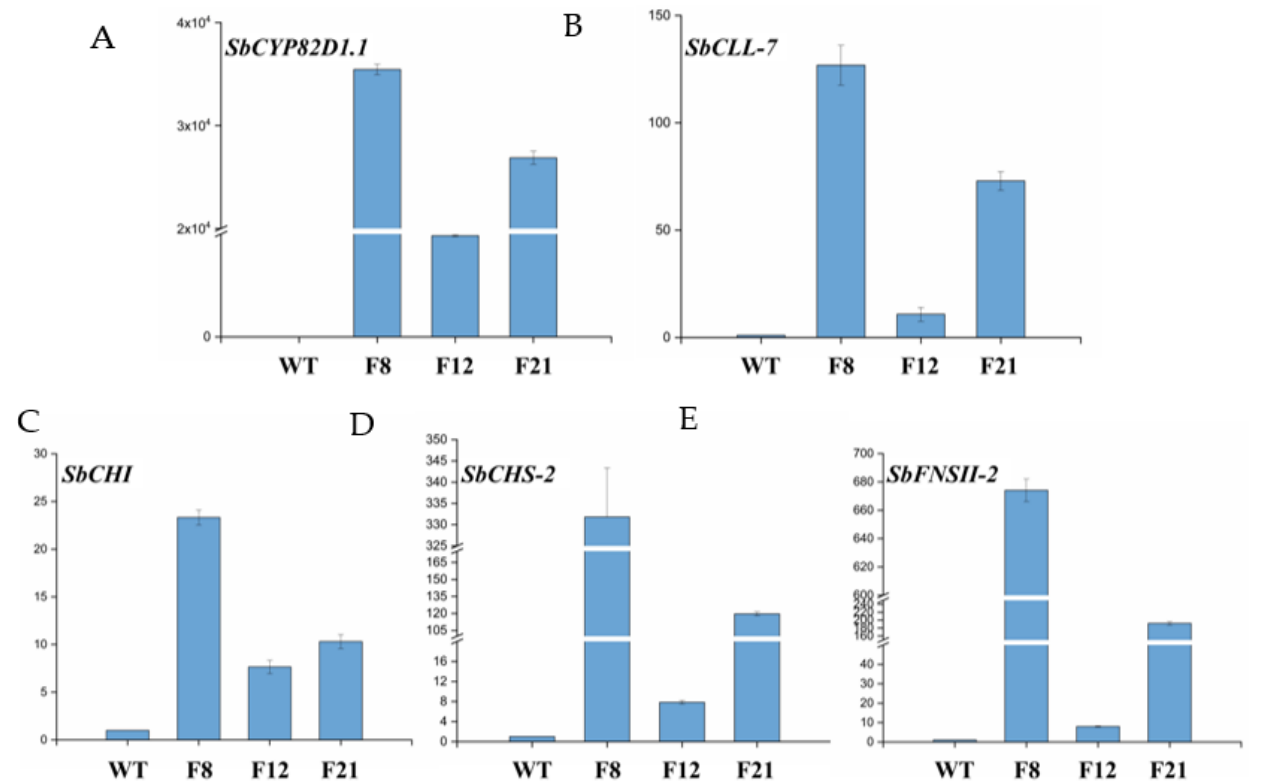
Figure 3. The relative gene-expression-level analysis of candidate genes in the transgenic Micro-Tom tomato plants and WT plants. ( A ) The relative expression-level analysis of SbCYP82D1.1 . ( B ) The relative expression-level analysis of SbCLL-7 . ( C ) The relative expression-level analysis of SbCHI . ( D ) The relative expression-level analysis of SbCHS-2 . ( E ) The relative expression-level analysis of SbFNSII-2 . WT: wild-type Micro-Tom tomato plants. F8, F12 and F21: transgenic tomato plants. Leactin gene from Lycopersicon esculentum was used as the reference gene. The data are represented as mean ± SD for the three independent experiments.